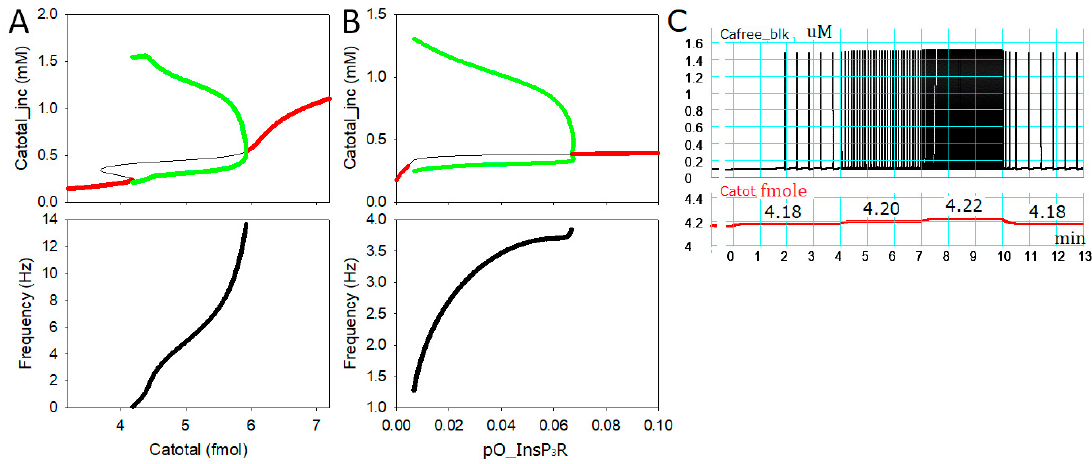
Figure 1. Bifurcation diagrams of the Ca 2 + dynamics model: ( A ) A bifurcation diagram with the total Ca 2 + content within the cell on the abscissa and total amount of Ca 2 + within the junction space ( jnc ; [Ca 2 + tot ] jnc ) on the ordinate (upper) and the corresponding frequency is shown with the same parameter as in the upper panel on the abscissa (bottom); ( B ) a bifurcation diagram with the open probability of type II inositol 1,4,5-trisphosphate receptors (pO_InsP 3 R) on the abscissa and total amount of Ca 2 + within the jnc ([Ca 2 + tot ] jnc ) on the ordinate (upper) and the corresponding frequency is shown with the same parameter as in the upper panel on the abscissa (bottom). Stable equilibrium points, unstable equilibrium points and stable limit cycles were plotted in red, black and green respectively in the upper panels of A and B; ( C ) results of time integration calculated using the same Ca 2 + dynamics model as in (A). Ca tot was changed as indicated in the lower panel in ( C ), and the spontaneous frequency was 0.04, 0.16, and 0.29 Hz at 4.18, 4.20, and 4.22 femtomole Ca tot , respectively. Note, the Ca 2 + transient ([Ca 2 + ] blk ) is plotted in ( C ) instead of [Ca 2 + tot ] jnc in the bifurcation diagram. The [Ca 2 + ] jnc is the key factor initiating the spontaneous Ca 2 + release.